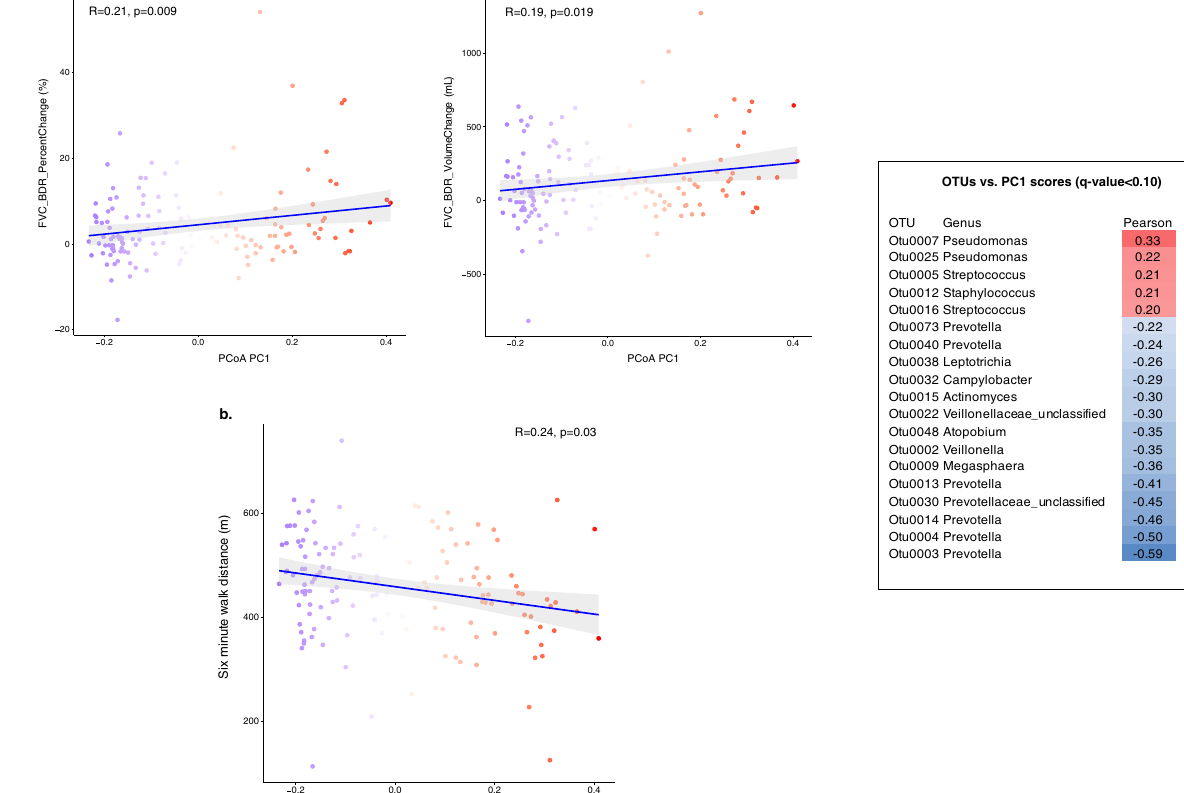
Fig. 3 Post-bronchodilator FVC response and 6-min walk distance correlate with variation in lung bacterial composition along principal component 1, which explained 23.5% of the total variation in lung bacterial community structure among ever-smokers. Each dot represents an individual BAL sample and is colored according to its PC score. OTUs contributing signi fi cantly ( q -value < 0.10) to PC1 are shown in the accompanying table, ranked by Pearson ’ s correlation coef fi cient. The relative abundances of Prevotella, Pseudomonas , and Streptococcus are primary drivers of PC1 variation. a Post-bronchodilator FVC response measured by change in percent and volume in mL. b Six-minute walk distance